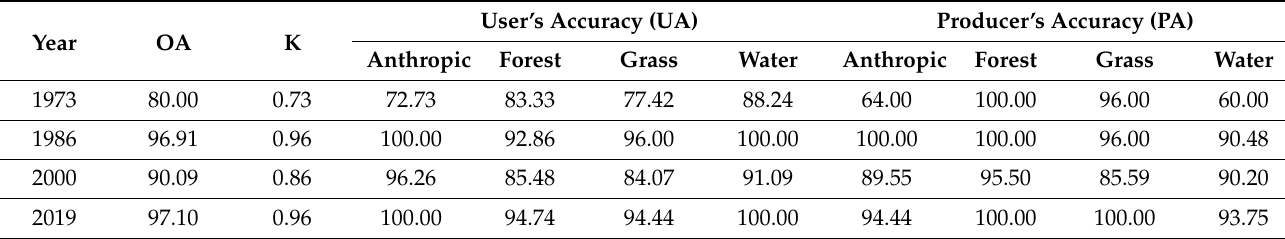
Table 2. Accuracy indices for classified images for the Hola Basin, Northeast China. Presented are overall accuracy (OA), kappa coefficient (K), user’s and producer’s accuracy for the classes anthropic, forest, grass, and water. All values are represented in percentage, except for kappa values, which range between 0 and